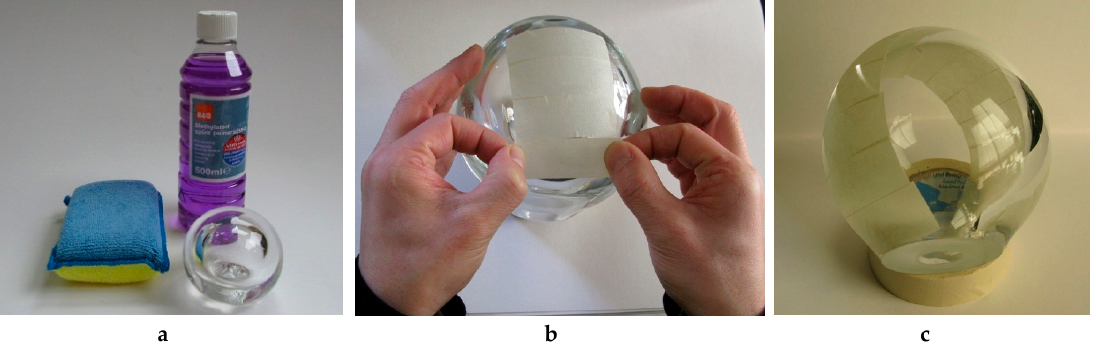
Figure 3. Applying masking tape to the surface of the parison.